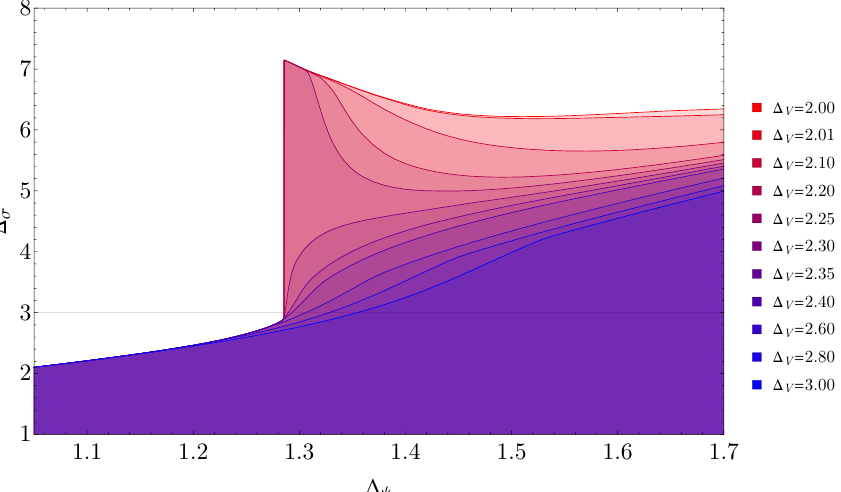
near the jump at Λ = 27. The red short vertical σ and are not error-bars. ψ